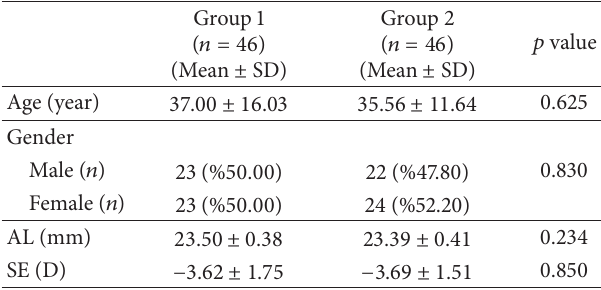
Table 1: Demographic data, mean axial length, and spherical equivalent of